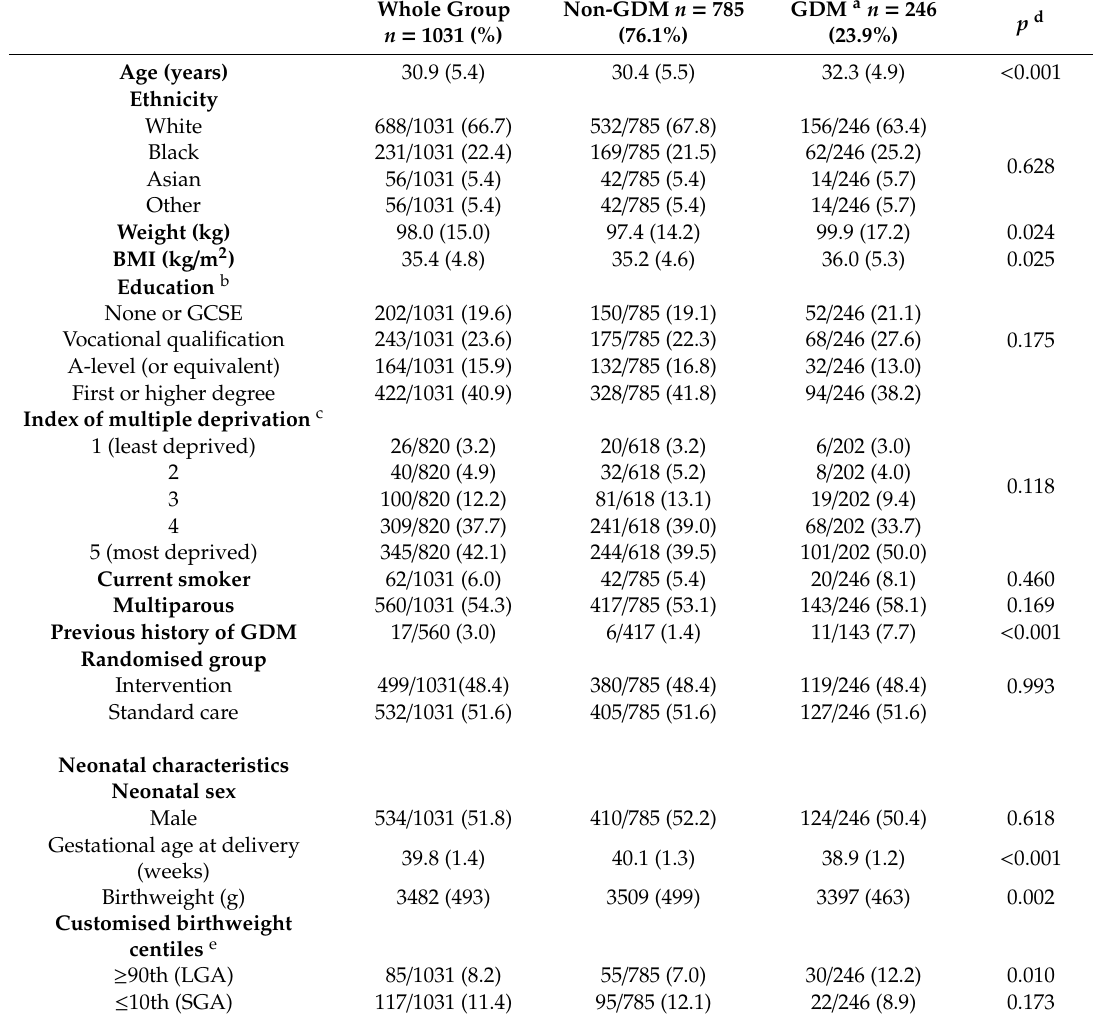
Table 1. Characteristics at 15 + 0 –18 + 6 weeks’ gestation of the study population who had an oral glucose tolerance